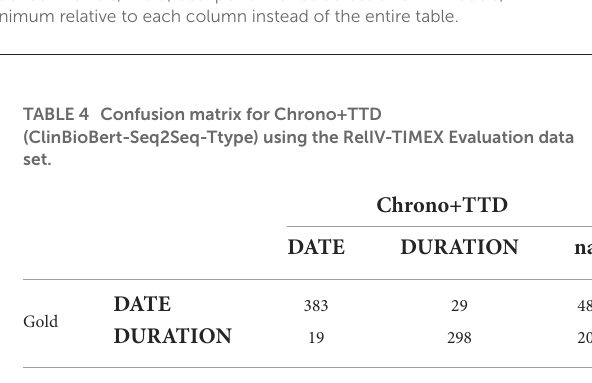
TABLE 5 Confusion matrix for MSRA using the RelIV-TIMEX Evaluation data